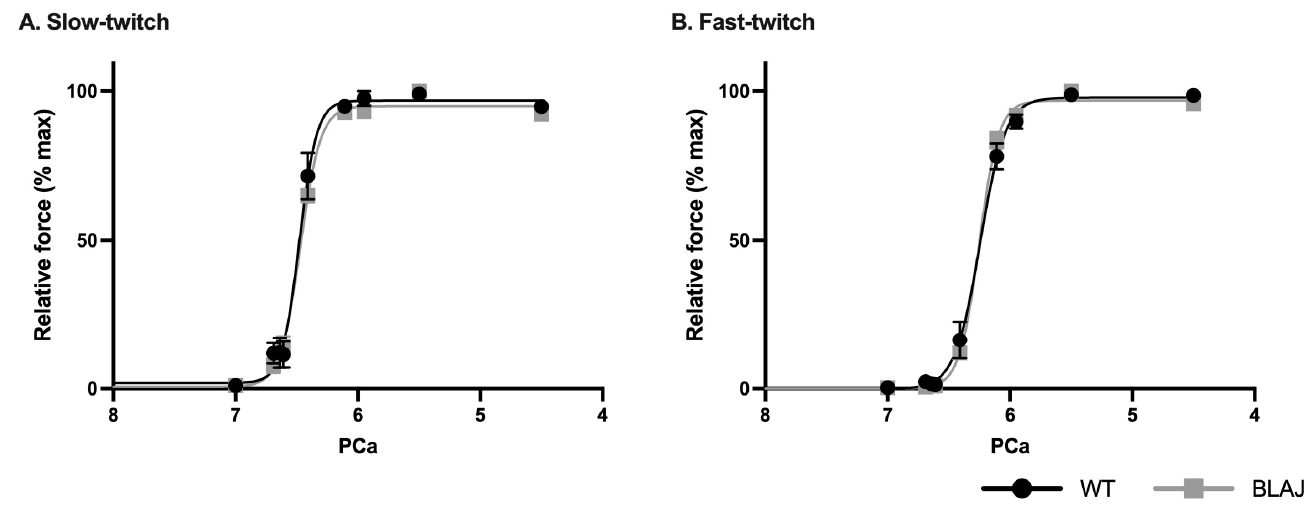
Figure 4. Force ‐ power of Ca 2+ (pCa) relationship of chemically skinned ( A ) slow ‐ and ( B ) fast ‐ twitch myofibers isolated from soleus and EDL muscles from normal WT and dysferlin ‐ deficient BLAJ mice aged 3 months. There were no strain ‐ specific differences for slow ‐ or fast ‐ twitch myofibers (classified by strontium sensitivity test) ( p > 0.05). Data are expressed as percentage of maximum force, presented as mean ± SEM ( n = 3–7). Table 2. Ca 2+ ‐ activation properties of chemically skinned slow ‐ and fast ‐ twitch myofibers isolated from soleus and EDL muscles from normal WT and dysferlin ‐ deficient BLAJ mice aged 3 months ( n = 2). There were no strain ‐ specific differences for slow ‐ or fast ‐ twitch myofibers (classified by stron ‐ tium sensitivity test) ( p > 0.05). Data are presented as mean ± SEM and analyzed by two ‐ way ANOVA. Number of isolated myofibers analyzed indicated by n values.